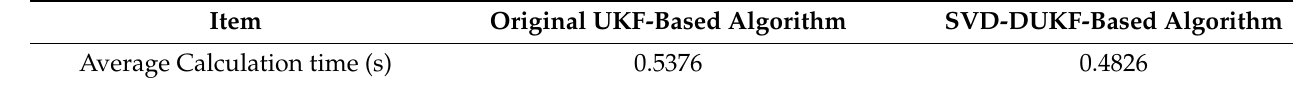
Figure 6. One Monte Carlo trial of the SVD-DUKF-based 3D RO-localization algorithm. Table 4. Average calculation